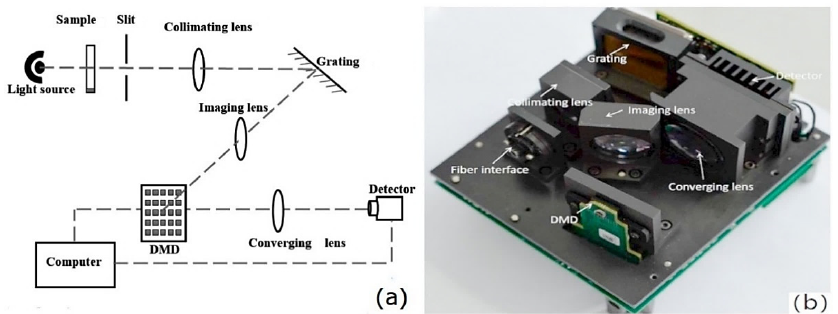
Figure 2. The implementation of a Hadamard-transform (HT) spectrometer by Lu et al. ( a ) Scheme of the optical system; ( b ) design of HT spectrometer. Reproduced (CC-BY 4.0 license) from [43]. Furthermore, while not being clearly superior in miniaturized form, the Michelson interferometer has been implemented in a number of compact NIR instruments, including those that achieved considerable commercial success; e.g., NeoSpectra sensors [5]. Nota- bly, a more recent generation of miniaturized FT-NIR spectrometers has emerged; for ex- ample, the Hefei SouthNest spectrometer. This design implements a relatively large mir- ror with a diameter of 3 cm in the interferometer, resulting in much improved optical throughput of the spectrometer compared with earlier generations of miniaturized FT- NIR devices. Michelson-interferometer-based sensors offer a wide operational spectral re- gion and superior resolution, comparable to those offered by benchtop FT-NIR spectrom- eters. In addition to the above examples, one alternative concept for a spectrometer consti- tutes an array detector with multiple independent photosensitive elements [5]. While ex- pensive, such a detector only needs to be combined with a relatively simple optical filter to work efficiently as a multichannel spectrometer that measures all wavelengths in the spectrum simultaneously without any scanning principle involved. This solution is par- ticularly beneficial for miniaturized instruments, as it involves no moving parts even at the microscale, a high mechanical resistance, and very compact dimensions. Among the solutions implemented in the current miniaturized NIR instruments, multichannel sen- sors based on a linear variable filter (LVF) deserve particular attention. An LVF works as a wedge-shaped optical filter with an optical coating of a different thickness, which creates a linear variation in the transparency of the filter at different wavelengths. Designs based on an array detector and an LVF, unlike those based on MOEMS, do not have the high initial investment costs that are characteristic of semiconductor manufacturing. An LVF element is very thin itself, allowing the construction of instruments with a very short path length, further improving the properties of the multichannel spectrometer with high op- tical performance. Since there is no movement in the operation of the spectrometer, acqui- sition of a single spectrum is possible with an integration time of less than 10 ns, resulting in the ability to average a large number of spectra in an overall short collection time [5]. 2.2.3. Detector Miniaturized NIR spectrometers are usually equipped with an indium gallium arse- nide (InGaAs) or “extended” InGaAs detector, although some instruments also contain